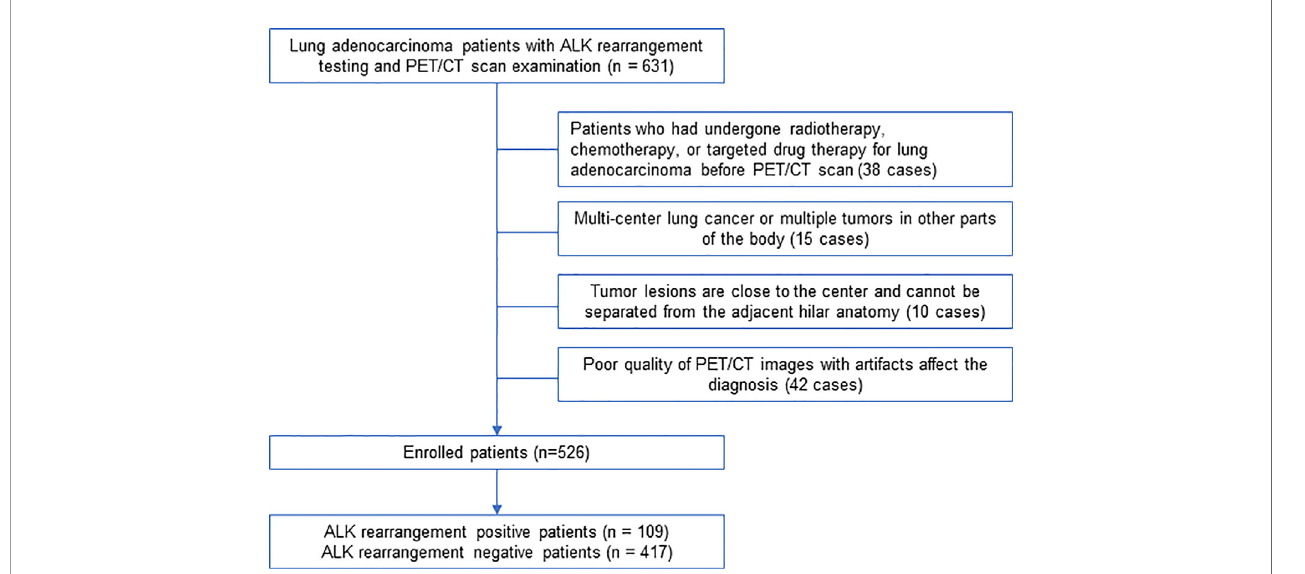
FIGURE 1 | Flowchart of lung adenocarcinoma patient